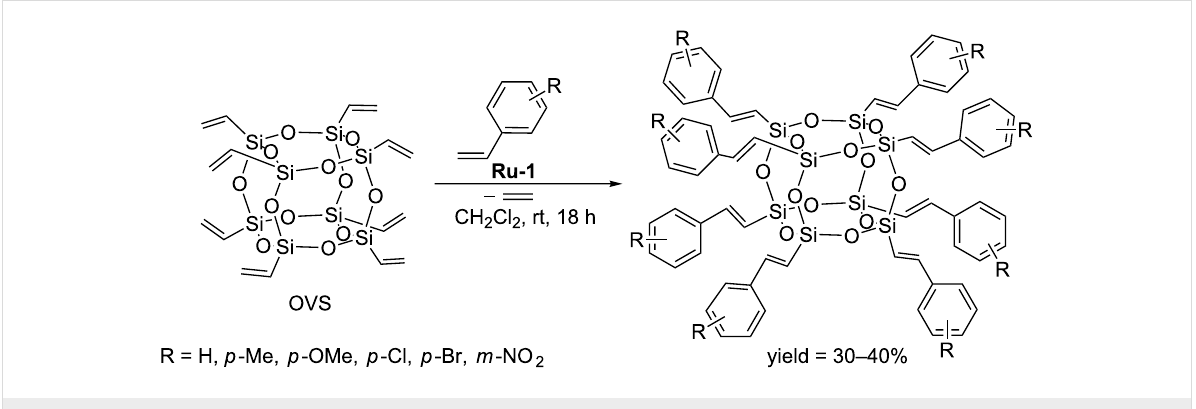
Scheme 4: Cross metathesis of OVS with substituted